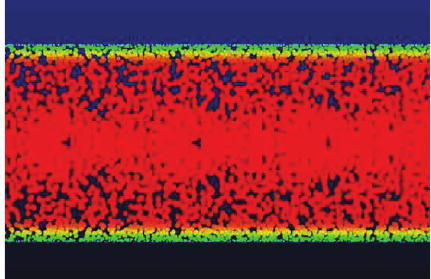
Figure 3: Schematic representation of particle positions based on the evaluation of the concentration of particles using the shear- induced particle migration